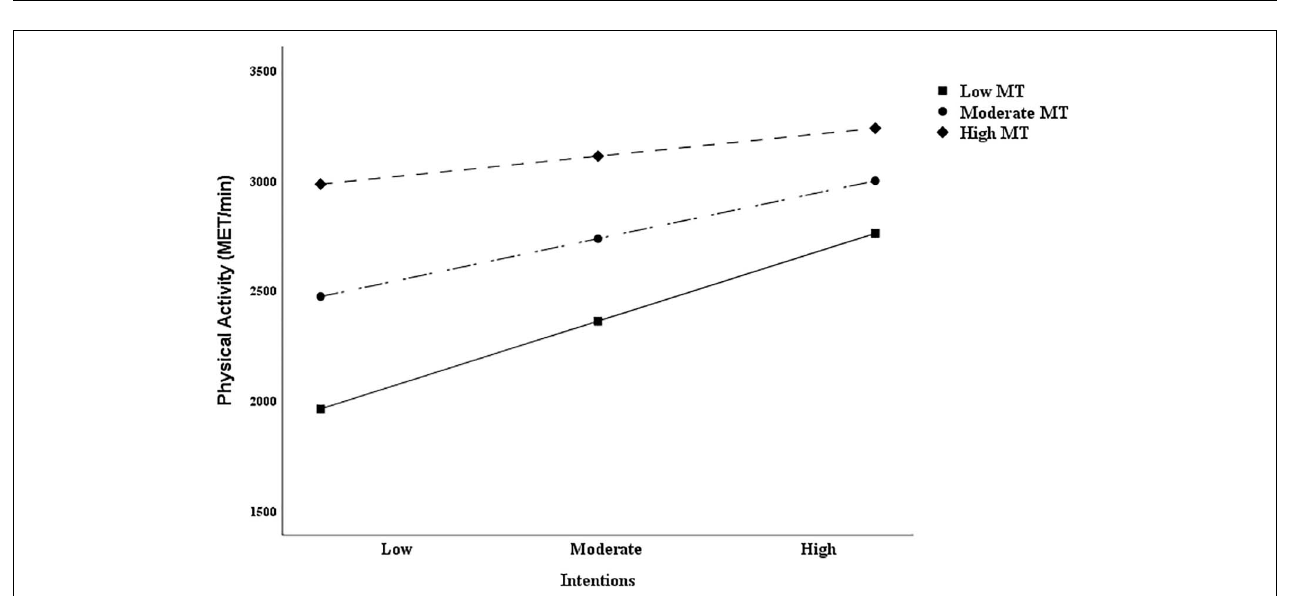
FIGURE 5 | Simple slopes for physical activity intentions and behavior relations at different mental toughness levels among college students.